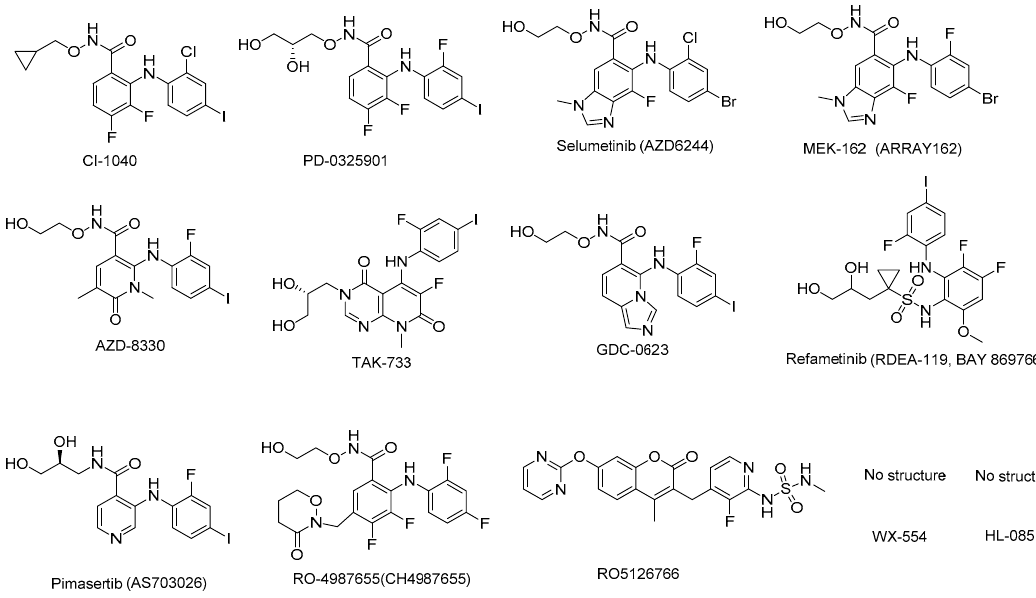
Figure 3. MEK inhibitors in clinical study.